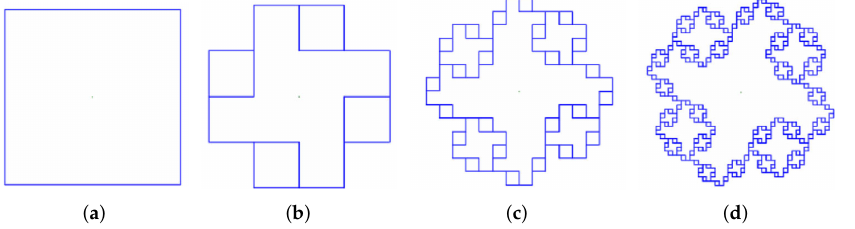
Figure 25. Fractal pattern generated through L-system method (Wang et al. [56]). ( a ) Initial element, ( b ) n = 1, ( c ) n = 2, and ( d ) n = 3.